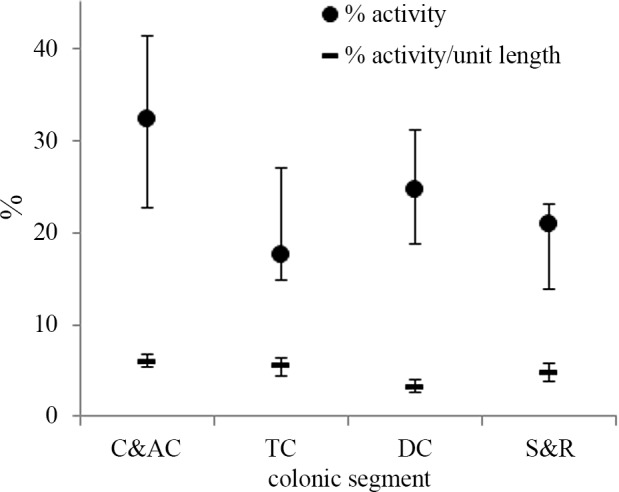
The 25th centile, median, 75th centile of the percentage activity (•) and percentage activity/unit length (˗) of 18FDG in the 4 sections of the colon